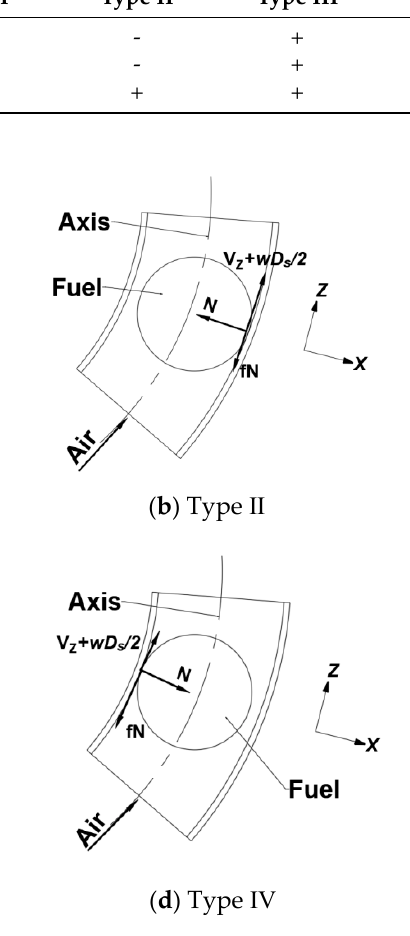
Figure 5. Atypical bend ‐ collision type.